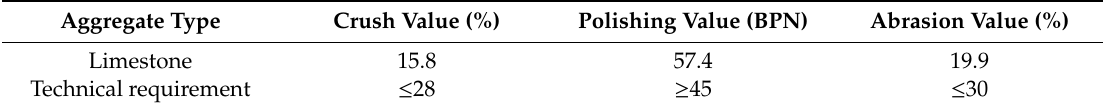
Table 5. Mechanical properties of